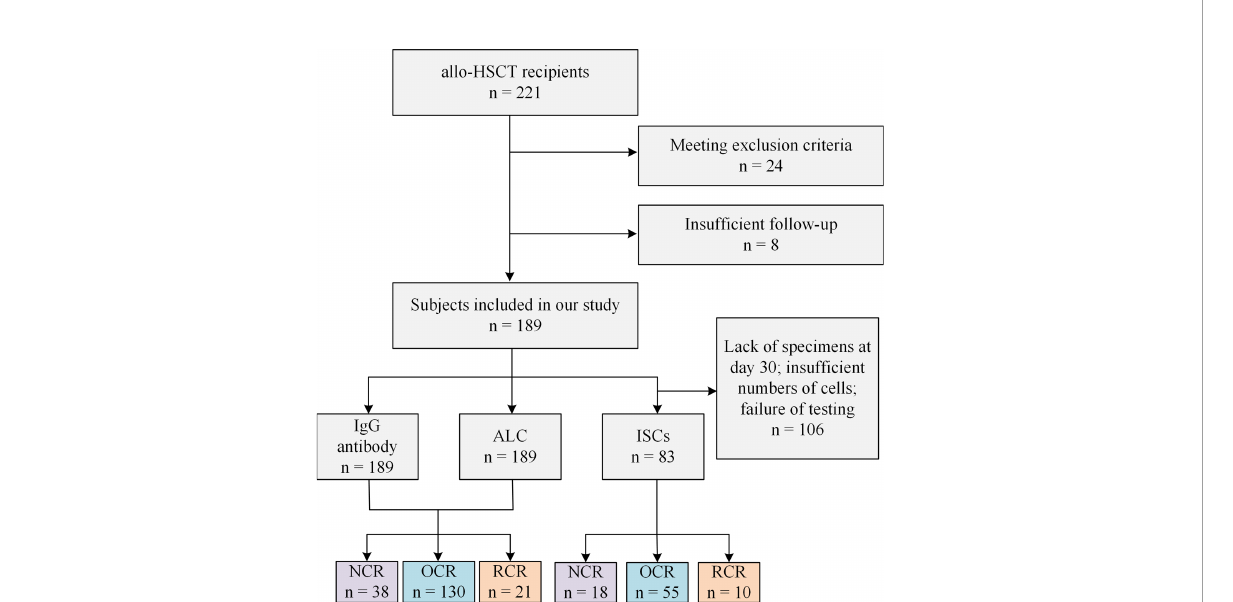
FIGURE 1 Study participant fl owchart. allo-HSCT, allogeneic hematopoietic stem cell transplant; ALC, absolute lymphocyte count; ISCs, HCMV speci fi c IFN- g secreting cells; NCR, recipients without HCMV reactivation; OCR, recipients with one episode of HCMV reactivation; RCR, recipients with recurrent HCMV